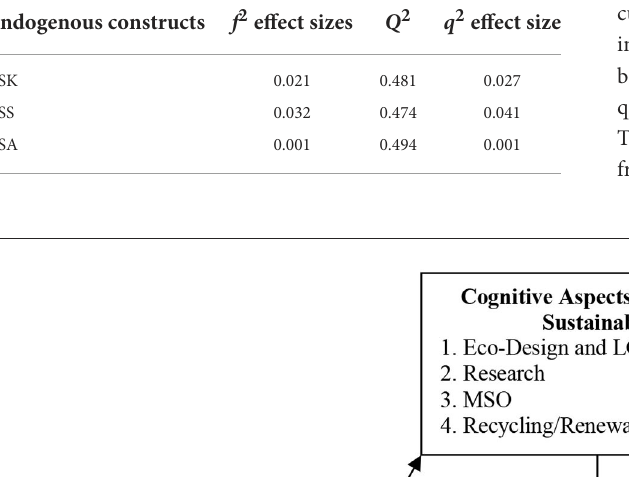
TABLE 6 f 2 effect sizes and Q 2 predictive relevance of the endogenous constructs.